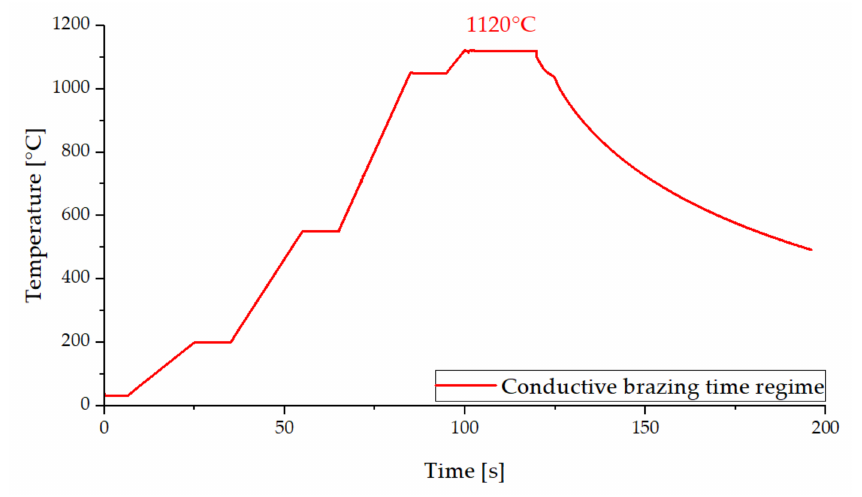
Figure 2. Temperature–time curve of the conductive brazing